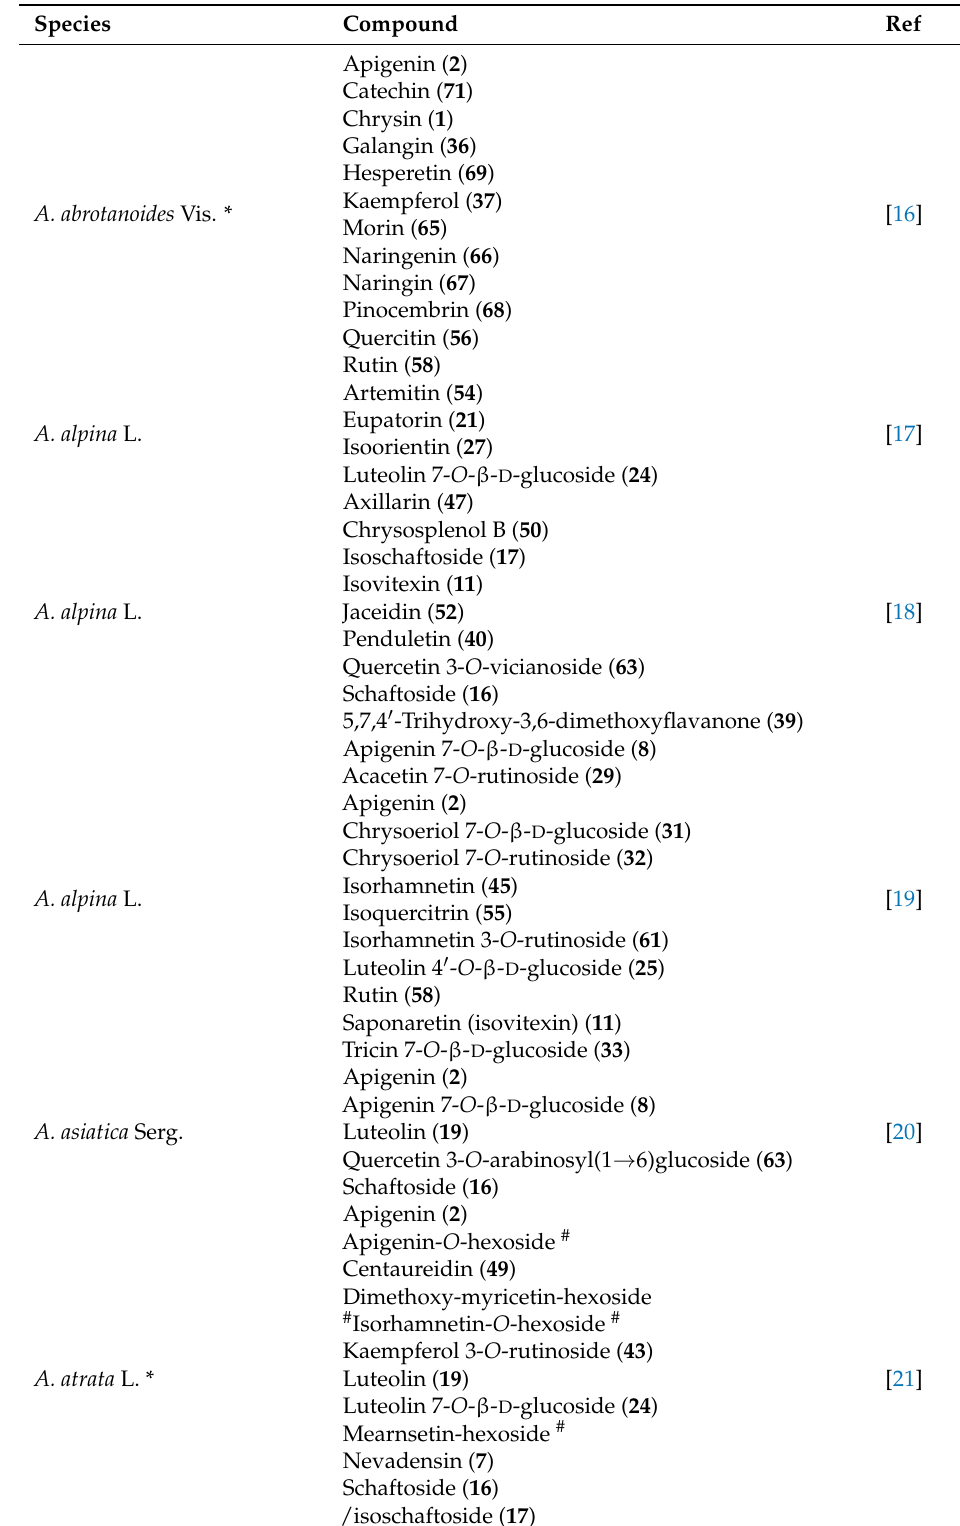
Table 2. Flavonoids from Achillea